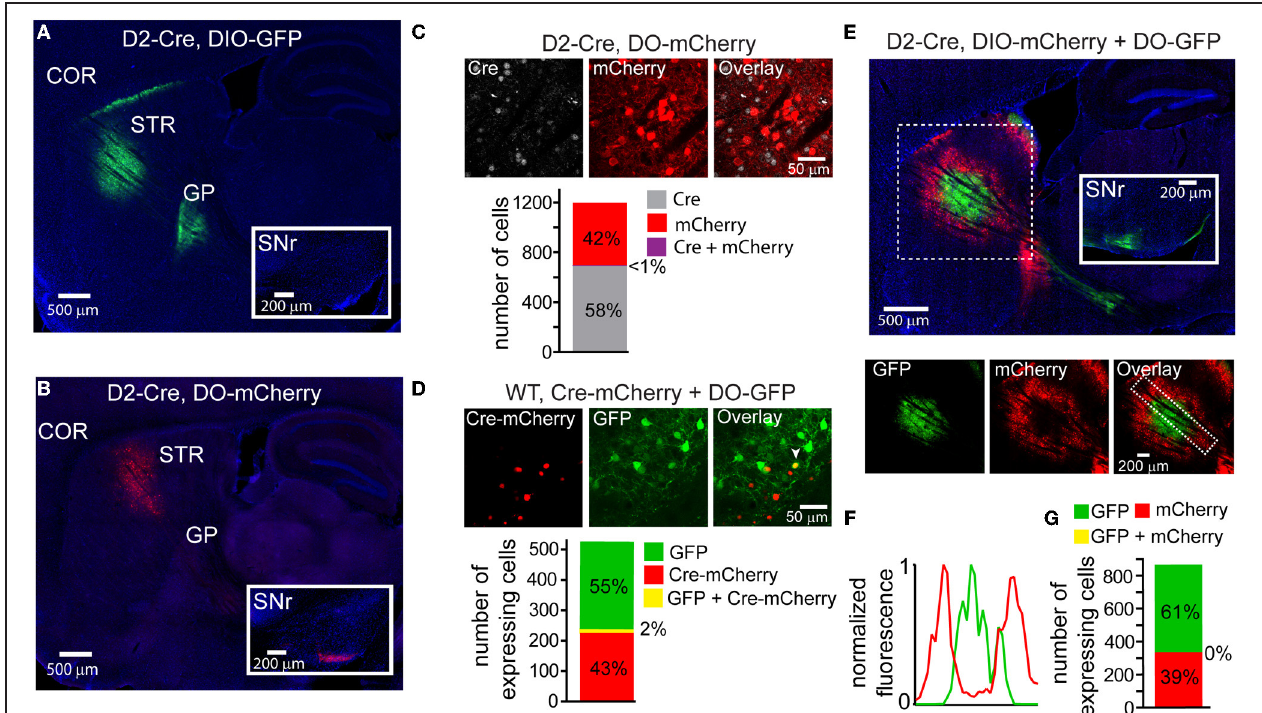
the striatum of a wild type (WT) mouse efficiently prevents GFP expression in Cre-mCherry expressing cells. Top, a single confocal plane containing interspersed mCherry + and GFP + cells. Note that the mCherry expression is nuclear due to nuclear targeting of Cre. The arrowhead indicates a cell co-expressing mCherry and GFP. Bottom , confocal imaging of infected tissue ( N = 2 infections, N = 521 cells) reveals that cells expressing Cre-mCherry ( N = 237) and cells expressing GFP ( N = 284) are largely non-overlapping ( N = 11 / 521 cells were double-positive for both fluorophores). (E) Sagittal section through a D2-Cre mouse infected with DIO-mCherry and DO-GFP in the striatum. Despite the physical intermixing of Cre positive and negative neurons in the striatum, the resulting GFP and mCherry expression is spatially segregated. Below , separate visualization of the green and red fluorescence channels demonstrates that mCherry is excluded from the striatal volume expressing GFP. (F) Normalized mean fluorescent values for GFP and mCherry quantified from boxed inset in E , bottom right . (G) Confocal imaging around the border regions ( N = 2 infections, N = 865 cells) containing both GFP + ( N = 529) and mCherry + ( N = 336) cells revealed no overlap in